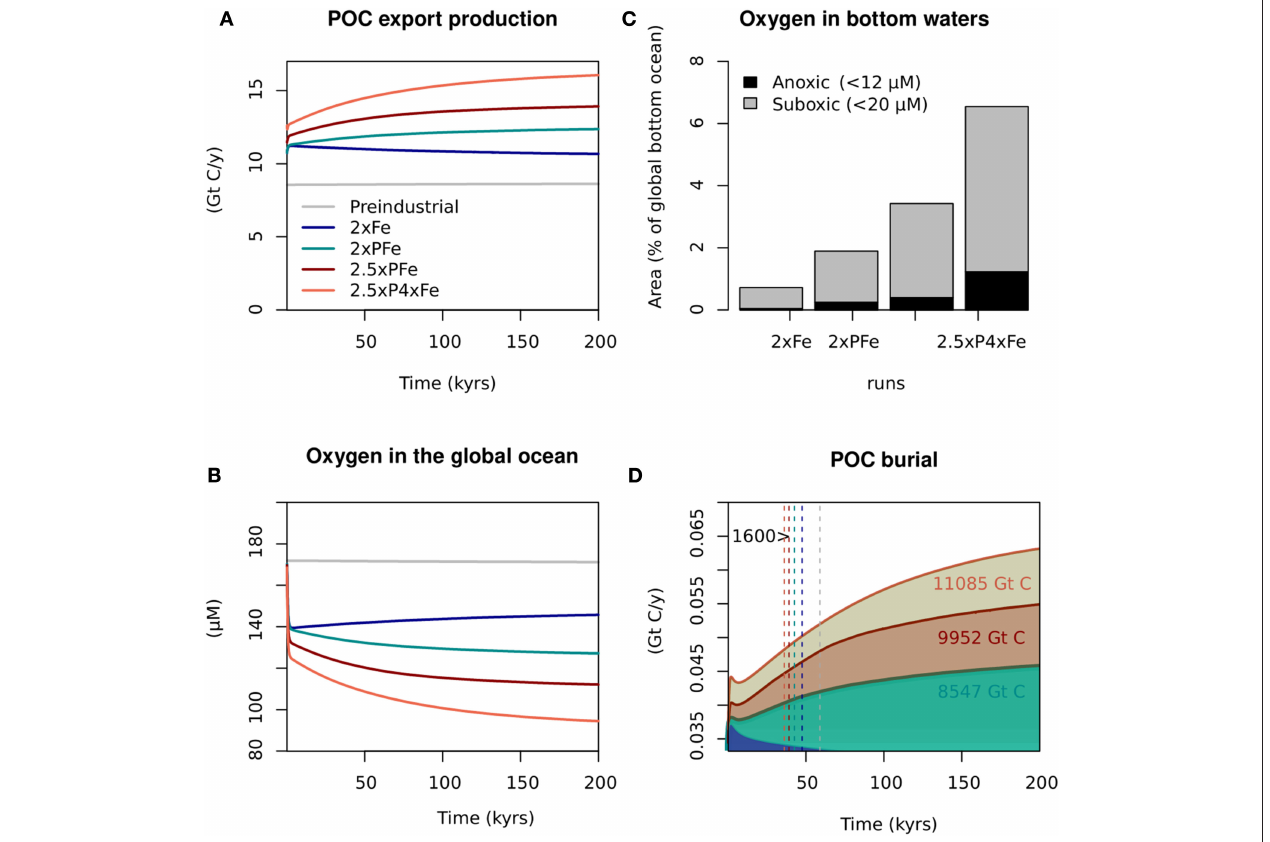
FIGURE 3 | Particulate organic carbon (POC) and oxygenation for key runs in this study. (A) POC export production, (B) global oxygen concentrations, (C) oxygen concentrations in bottom waters after 200 kyrs and (D) POC burial rates. Colored numbers in (D) indicate the total organic carbon permanently buried during the run (i.e., POC burial rates integrated over 200 kyrs). Colored dashed lines indicate the time needed for each respective scenario to remove 1,600 Gt of atmospheric carbon through organic burial